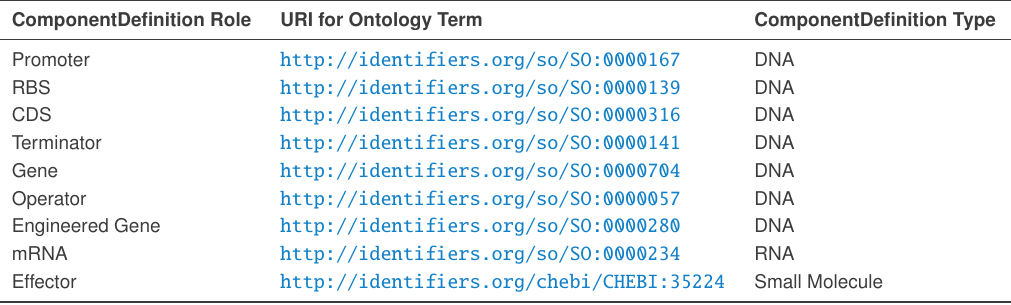
Table 4: Ontology terms to specify the roles property of a ComponentDefinition , organized by the type of ComponentDefinition to which they are intended to apply (see Table 2).